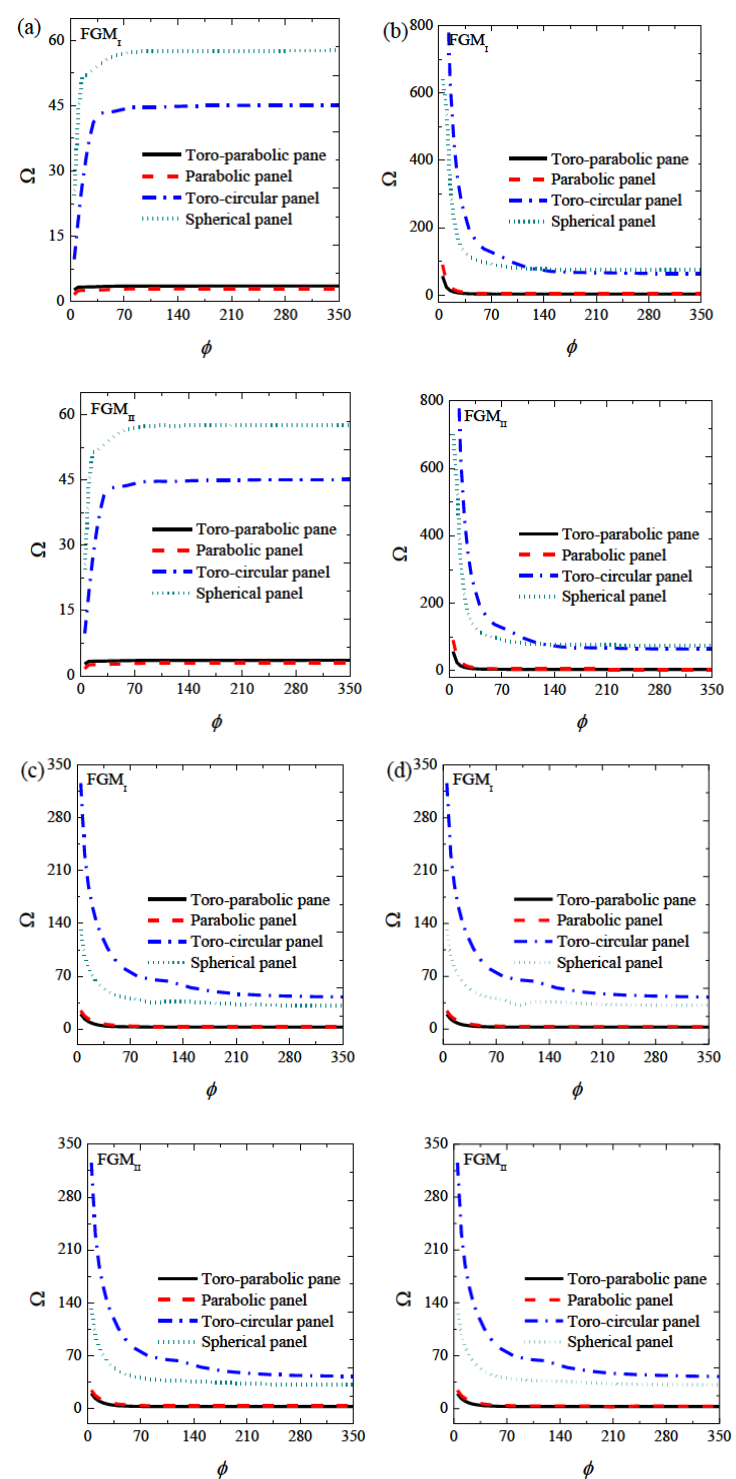
Figure 11: Variation of the frequency parameters Ω versus the angle of revolutions for FG panels: (a) CFCF; (b) CCCC; (c) E 1 E 1 E 1 E 1 ; (d) E 3 E 3 E 3 E 3